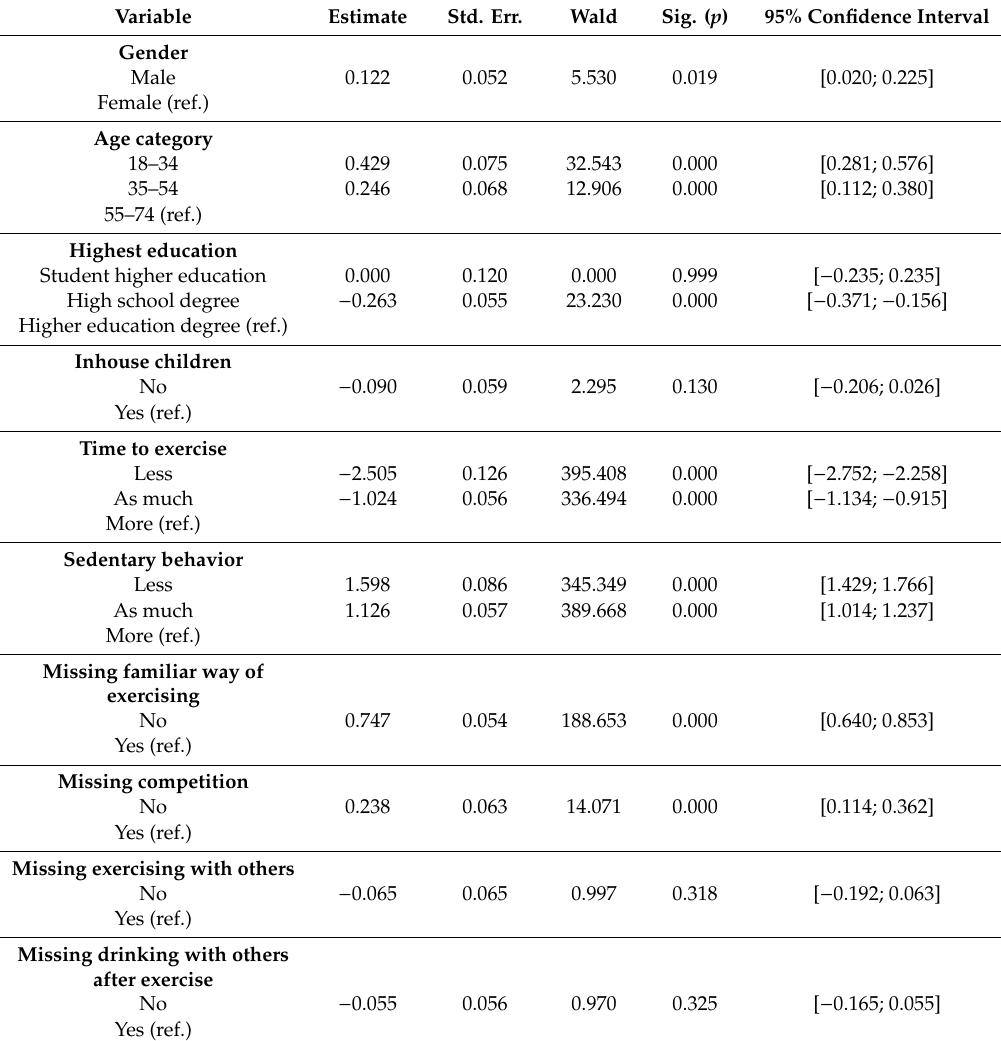
Table 3. Output ordinal logistic regression analysis of potential reasons for exercising less, as much, or more (subsample high active people, n = 11,763). Estimate Std. Err. Sig. ( p